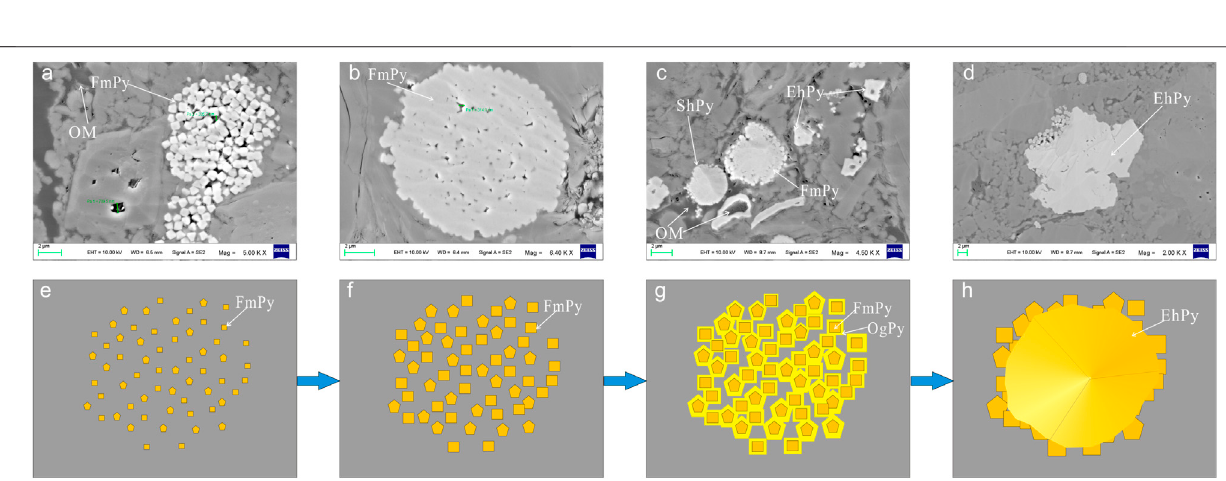
Frontiers in Earth Science |